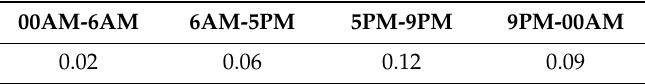
Table 5. Dynamic electricity charges.